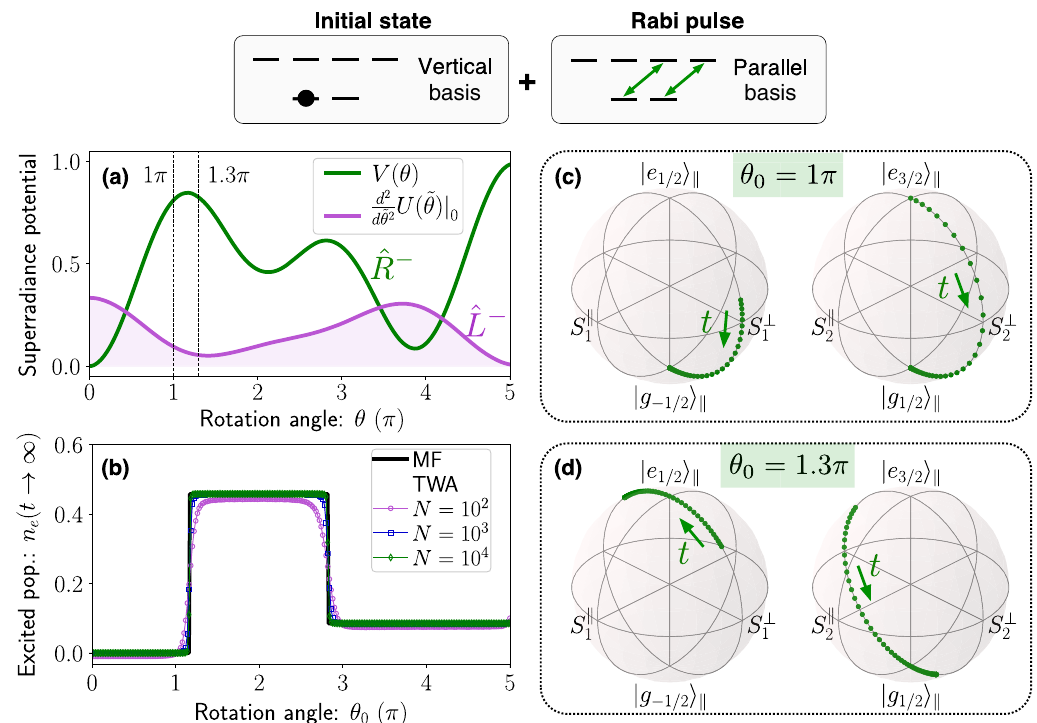
1 = 2 ; 3 = 2 Þ starting in ; F g e Þ ¼ ð ˆ R − decay and the curvature of the ˆ L −